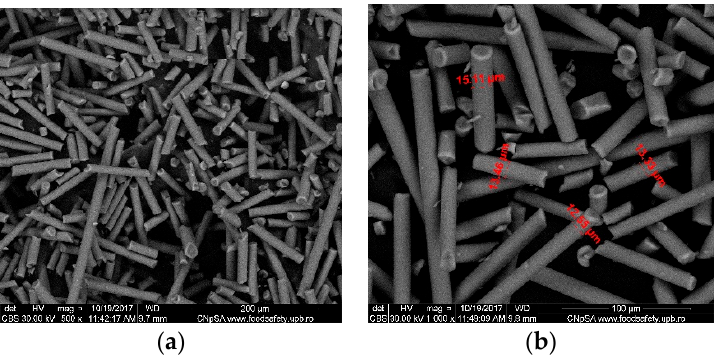
Figure 2. Morphologically characterized optical silica microfiber: Assemblies ( a ) and detail of the fiber diameter ( b ).